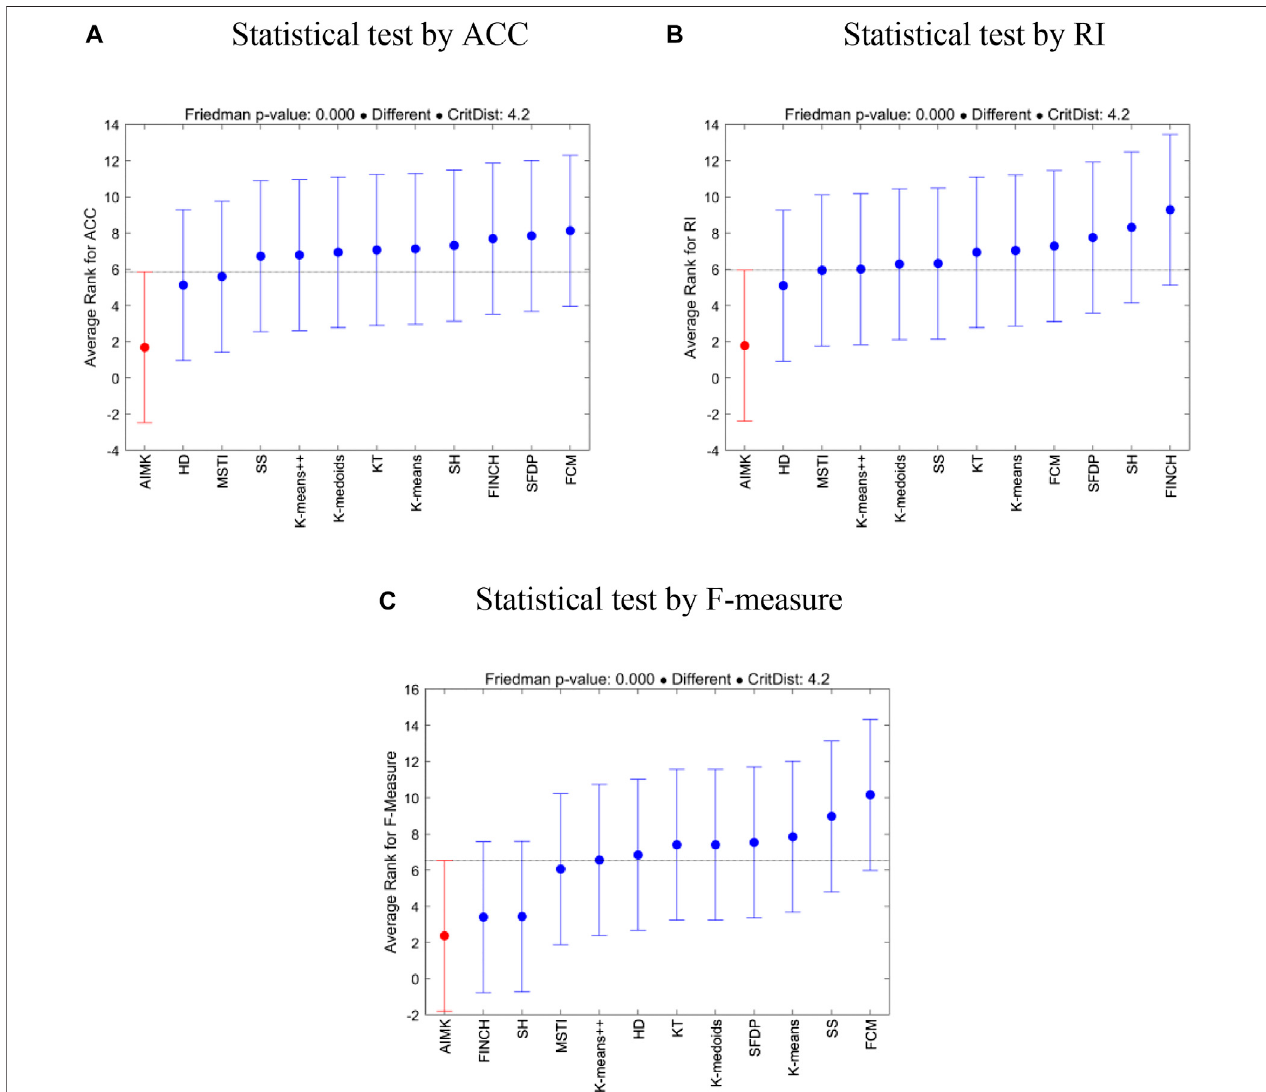
FIGURE 2 | MCB test for AIMK and the compared